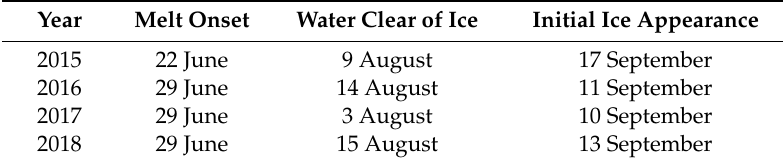
Table 1. Cut-o ff dates used to restrict the date range for the determination of ice-o ff and ice-on based on Sentinel-1